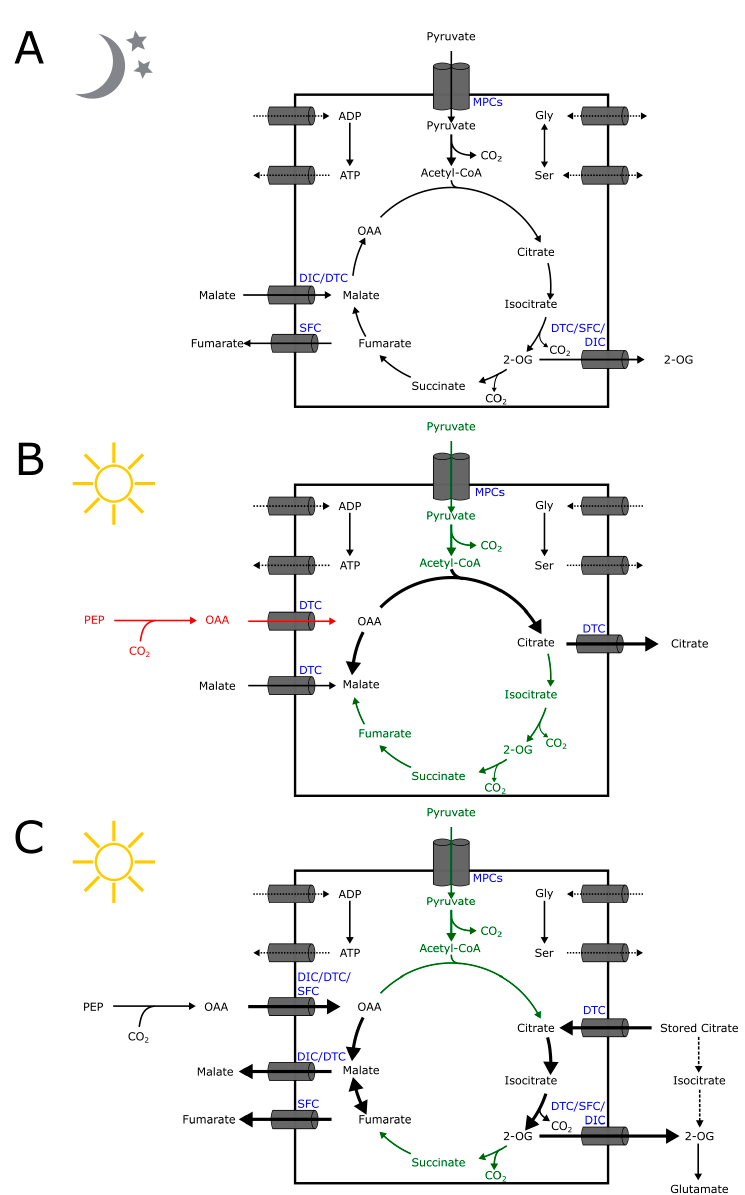
Figure 2. The plant central metabolism related to the mitochondrial Organic Acid Transporters ( A ) In the dark, the TCA cycle most likely operate in the familiar cyclic mode. ( B ) Non-cyclic TCA flux mode has been modeled based on enzymatic kinetic analysis during the day [37,41] ; flux in red is based on non-modeling literature. ( C ) A non-cyclic flux mode of the TCA cycle based on isotope labeling studies [42] , an alternative metabolic route of stored citrate is shown as broken black arrows. Fluxes shown in green are either inactive or significantly reduced.